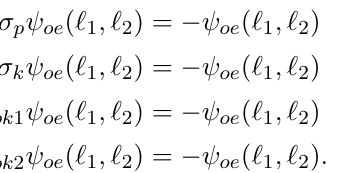
is the restricted solution (5.73) while the two general ( r ) = ( r ( p ) r ( p )) − 2 ( r ( k ) r ( k )) − 1 and z = ( r ( p ) r ( p )) − 2 ( r ( k ) r ( k )) − 2 . The r 1 2 1 2 g 1 2 1 2 : { p = σ ). , p } ↔ { k , k } being a composition, e.g. σ ◦ σ ◦ σ 1 2 2 1 p pk 2 pk 2 k pk 1